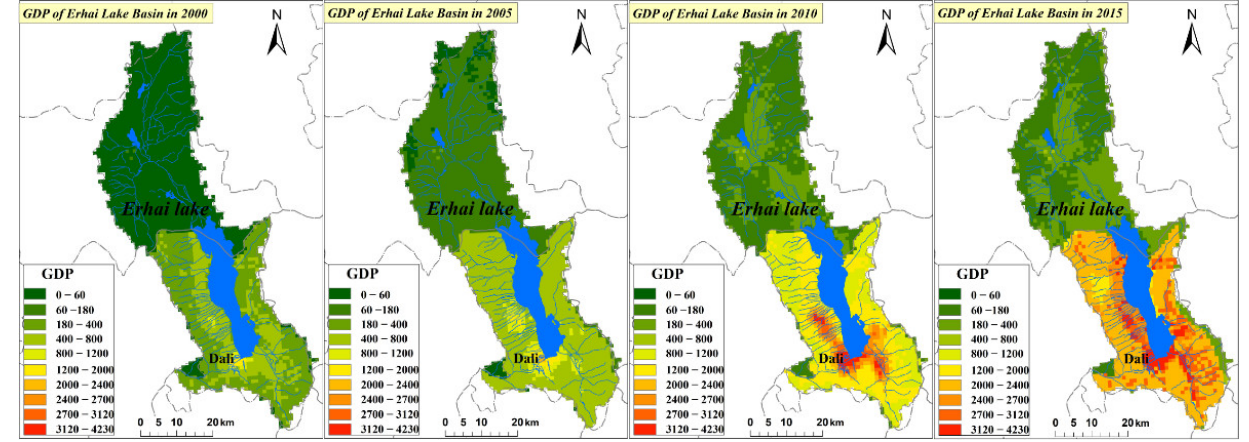
Figure 8. Spatial distribution of Erhai Lake GDP from 2000 to 2015 (unit: 10 4 yuan).